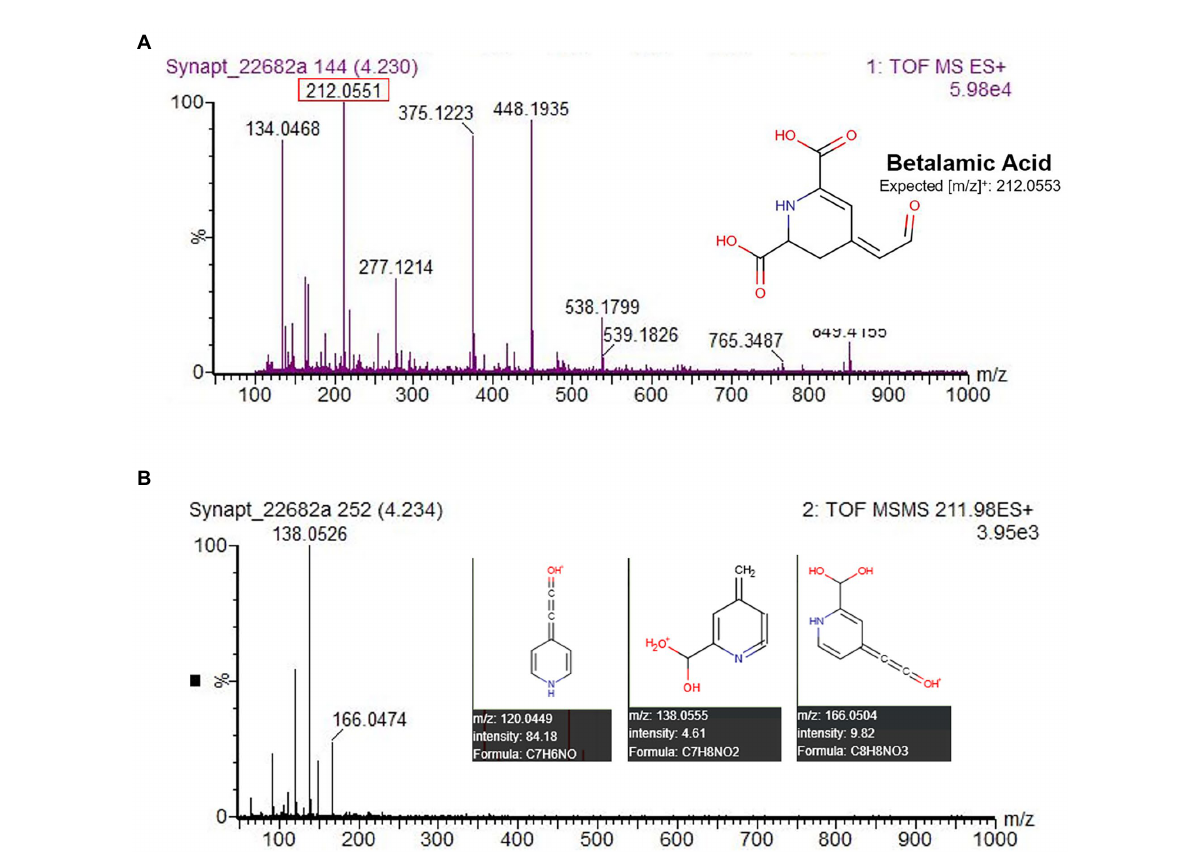
FIGURE 5 HPLC-MS–MS identification of betalamic acid in A. cruentus ‘Hot Biscuits’ (Wild Garden Seed) stem tissue. The protocol was used for analysis with the substitution of solvent A as 100% water and solvent B as 100% acetonitrile. MS–MS data (B) matched predicted [m/z] by the Human Metabolome LC–MS database (Wishart et al., 2018), confirming its